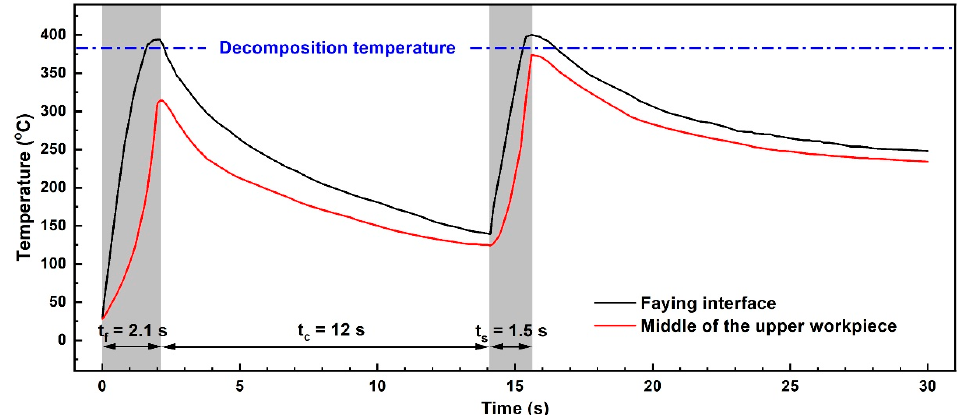
Figure 5. Temperature histories during double-pulse ultrasonic welding of CF/PA 66 composite.